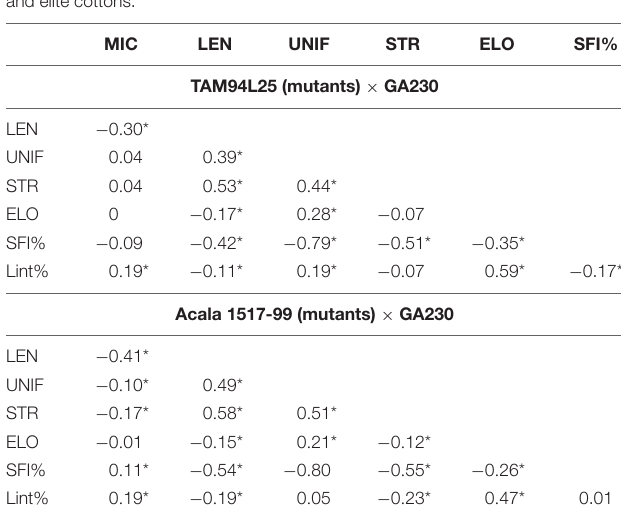
TABLE 4 | Correlation between fiber quality traits in crosses between mutant and elite